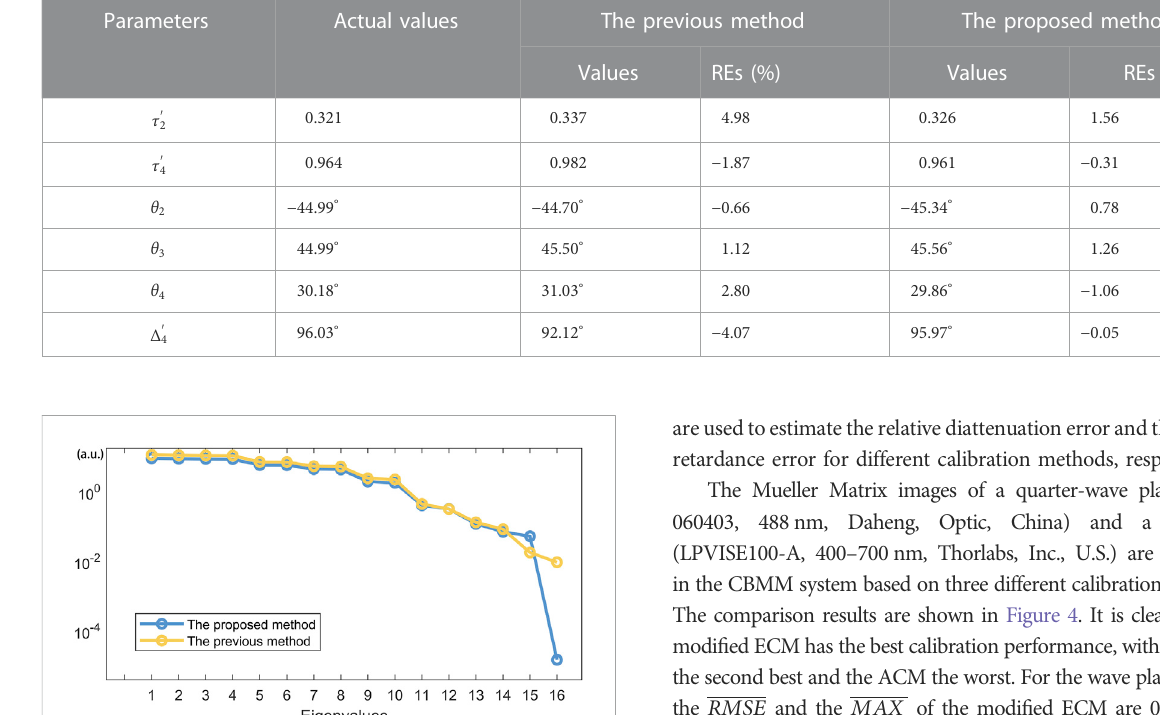
FIGURE 3 Comparison of the eigenvalues calculated by different